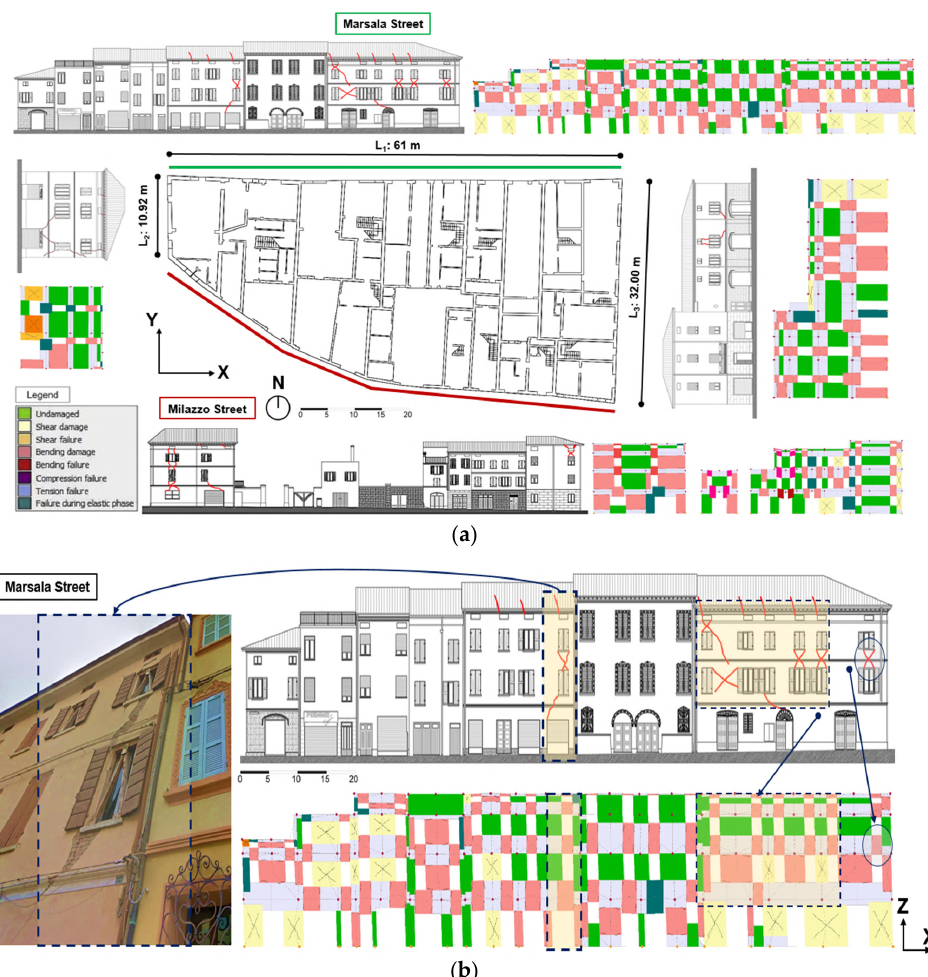
Figure 10. Validation of the mechanical model by comparison between real damages and numerical ones ( a , b ). The damages detected [30] are characterized by the widespread distribution of cracks in the main façade that affect the vertical structures.